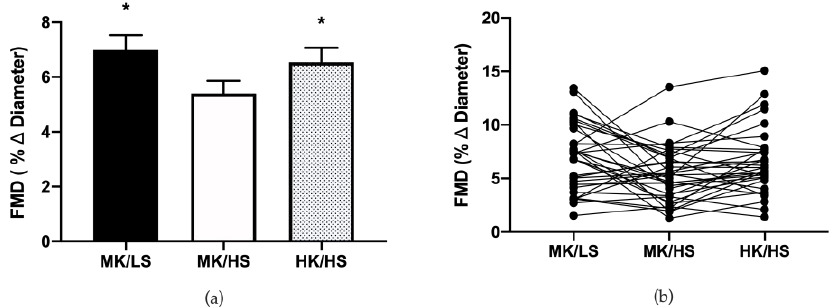
Figure 3. ( a ) Group brachial artery flow-mediated dilation (FMD) responses during the three diets. ( b ) Individual FMD responses during the three diets. Values are mean ± SE. FMD, flow-mediated dilation; HK/HS, high potassium/high sodium; MK/HS, moderate potassium/high sodium; MK/LS, moderate potassium/low sodium. * p < 0.05 vs. MK/HS.